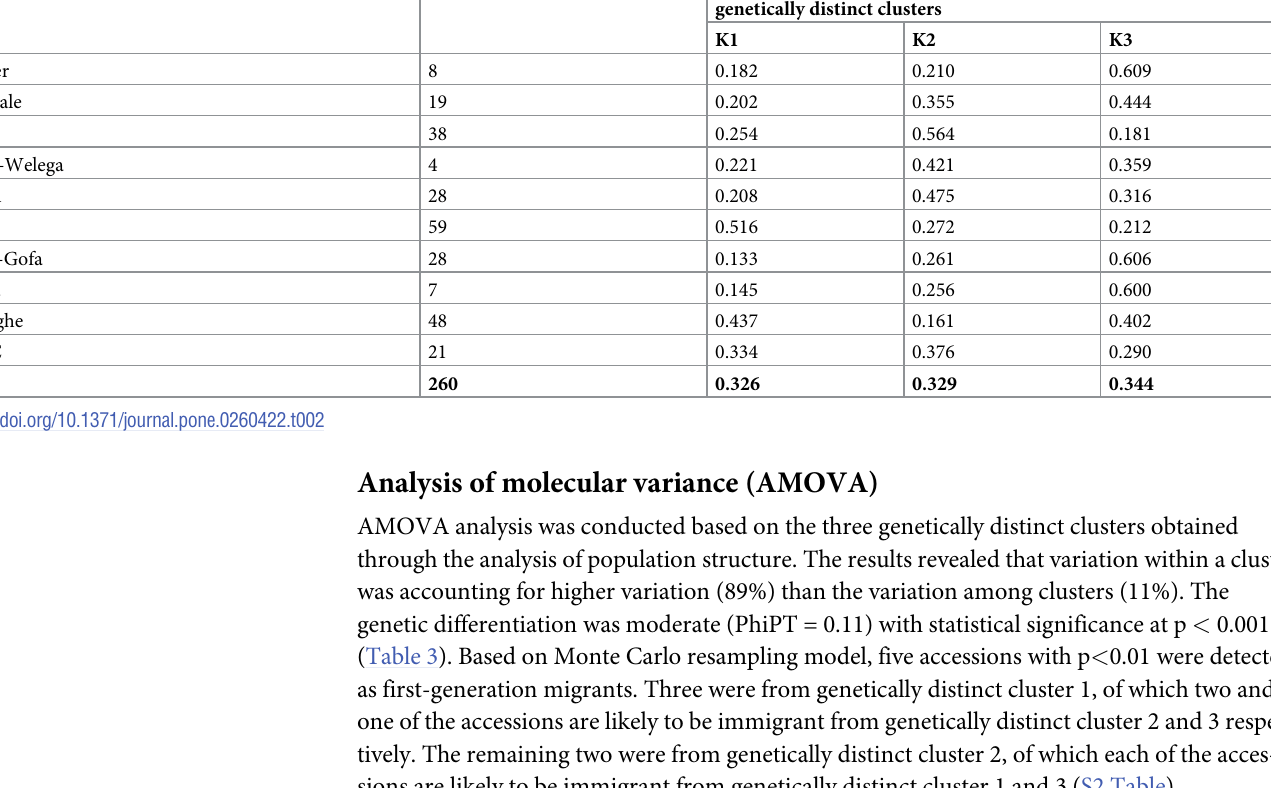
(Table 3). Based on Monte Carlo resampling model, five accessions with p < 0.01 were detected